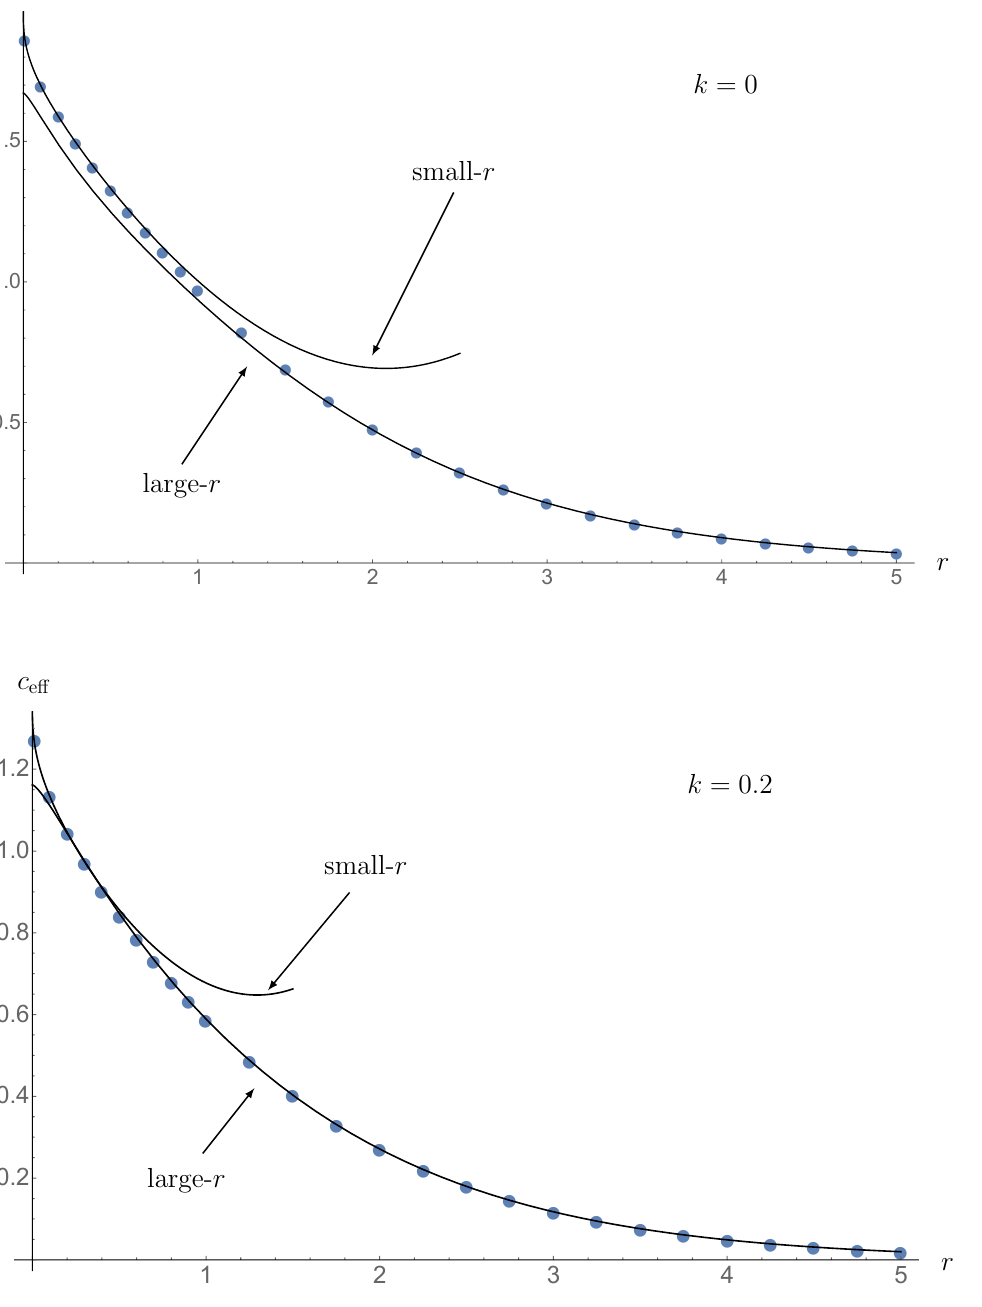
Figure 7 . c e(cid:11) (cid:17) (cid:0) 6 F ( r; k ) (5.23) plotted as a function of r = mR for n = 0 : 5 with k = 0 and k = 0 : 2. The dots were obtained from the numerical solution of the NLIE (5.30), (5.31). The small- r asymptotic comes from (5.24) while \large- r " represents (5.27). For the corresponding numerical data see table